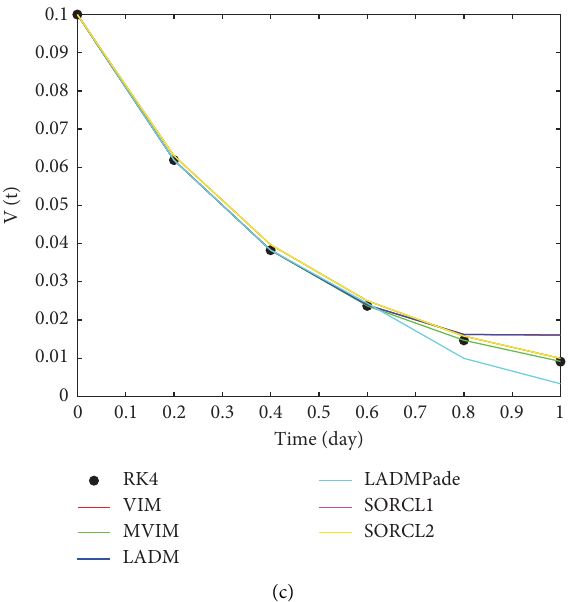
Figure 1: (a) Approximate values of T cells using methods: ode15s, VIM, MVIM, LADM, LADM-Pad`e, SORCL1, and SORCL2. (b) Approximate values of I cells using methods: ode15s, VIM, MVIM, LADM, LADM-Pad`e, SORCL1, and SORCL2. (c) Approximate values of V cells using methods: ode15s, VIM, MVIM, LADM, LADM-Pad`e, SORCL1, and SORCL2.